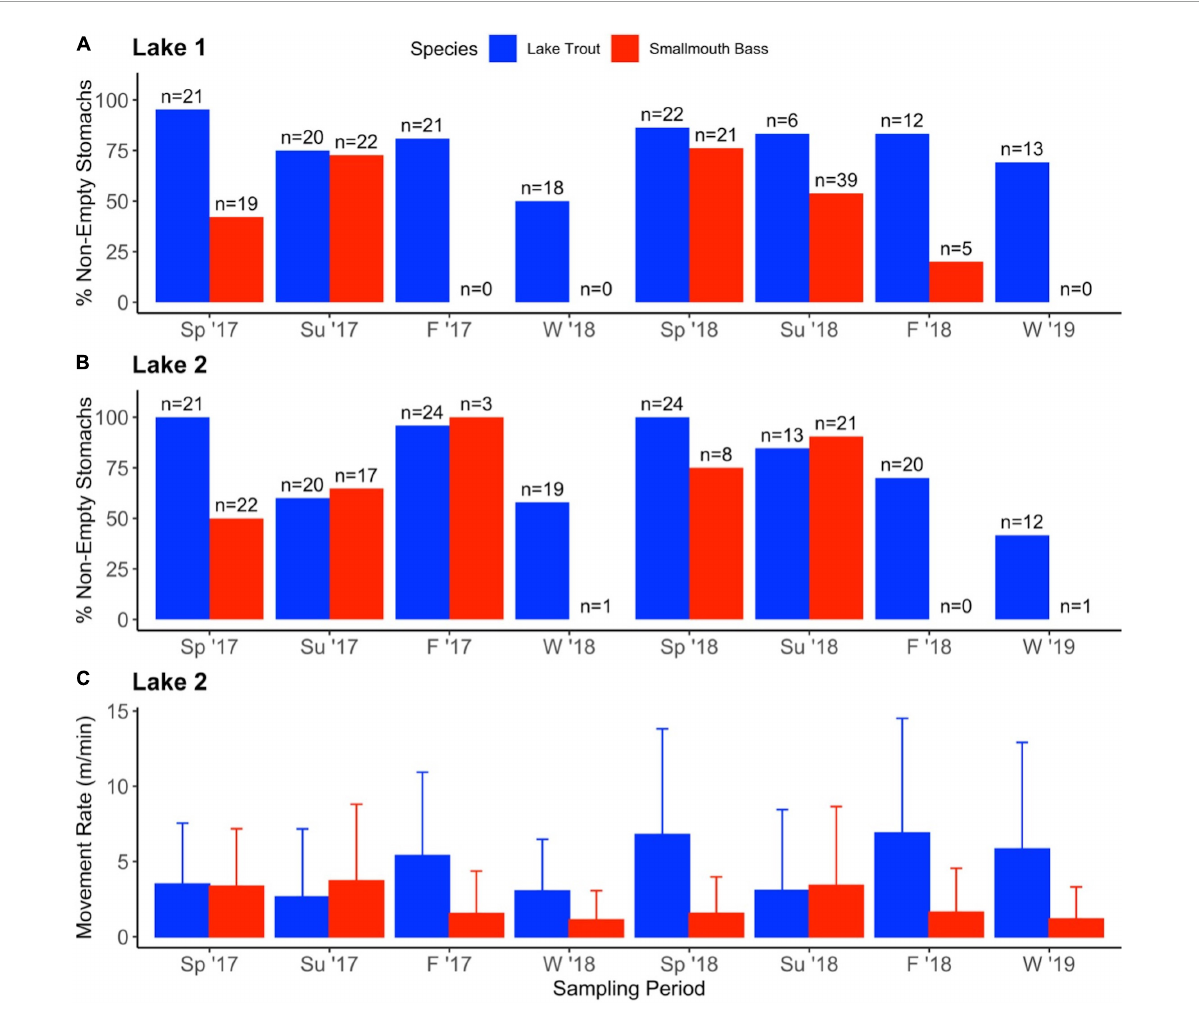
FIGURE4 Activity of lake trout (blue) and smallmouth bass (red) over four seasons and 2 years. The percent of stomachs sampled that had contents in Lake 1 (+ cisco; A ) and Lake 2 (– cisco; B ), with the total number of fish that had stomachs sampled is denoted on top of each bar*. Mean (+ SD) seasonal movement rate of species (m/min) in Lake 2 based on acoustic telemetry data (C) . *Note that more lake trout were caught in the summer 2018 sampling period than were sampled for stomach contents because the individuals were used in further study (not presented